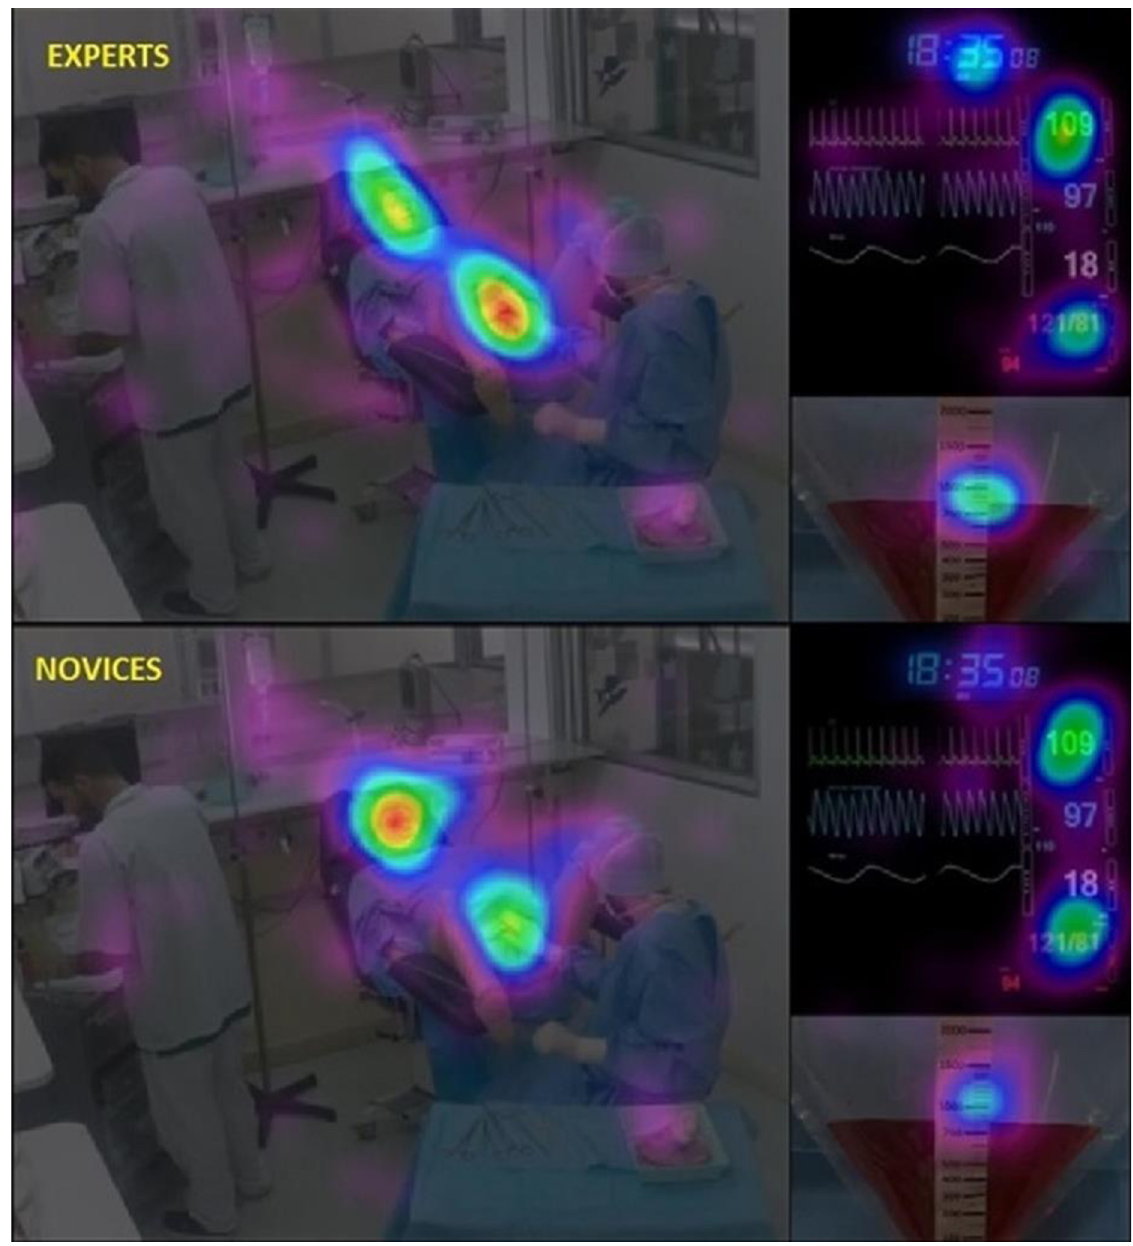
Fig 4. Heat map during the uterine revision step. Heat map calculated from anesthetists’ fixation points on video during the uterine revision step. The hotter the point (from blue to red), the greater the cumulative fixation time in the region of interest. Unlike the Novices (bottom), the Experts (above) showed a greater distribution of the gaze on the different elements of the scope. The interest in time and the blood collection bag appeared more important among the Experts. They paid a lot of attention to the perineal area whereas the Novices looked at Noelle’s face